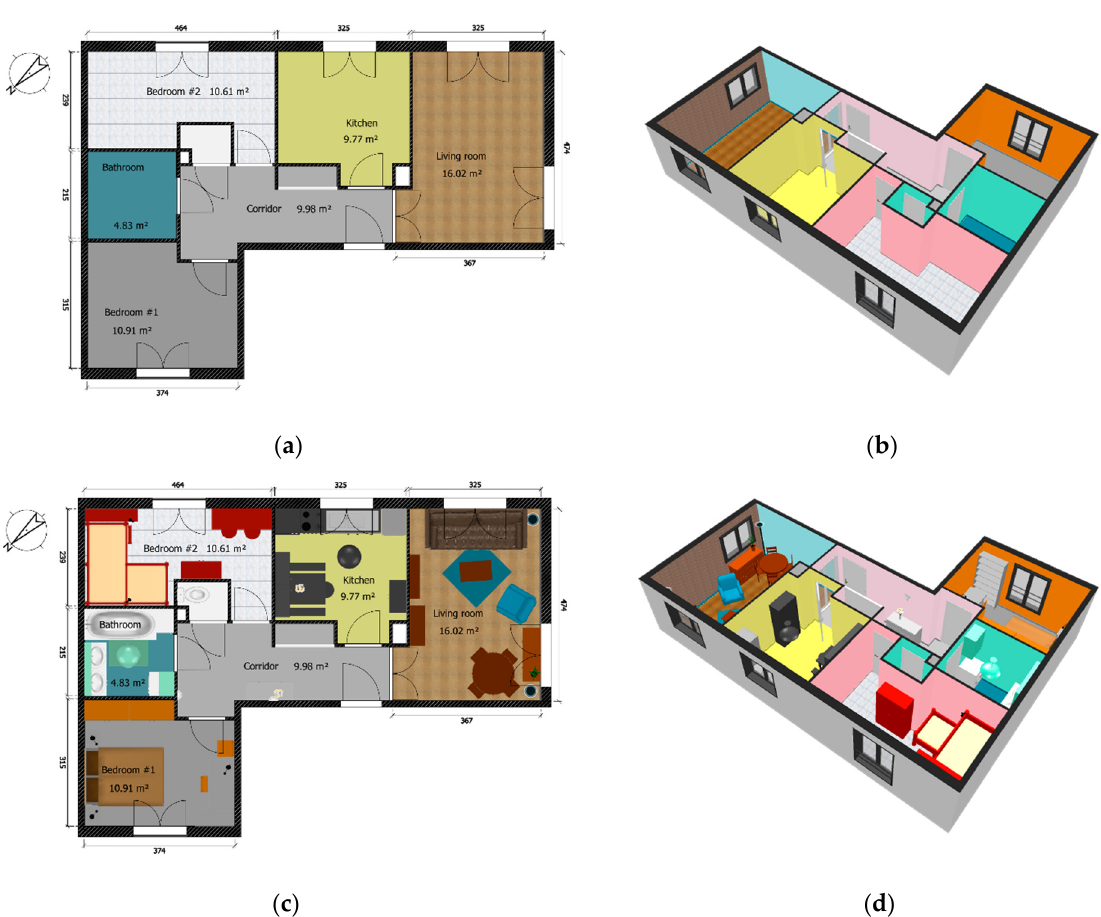
Figure 2. Design of an apartment using the software Sweet Home 3D: 2D plan and 3D representation of the unfurnished apartment are depicted in ( a , b ), respectively; ( c , d ) are the equivalents of furnished designs.